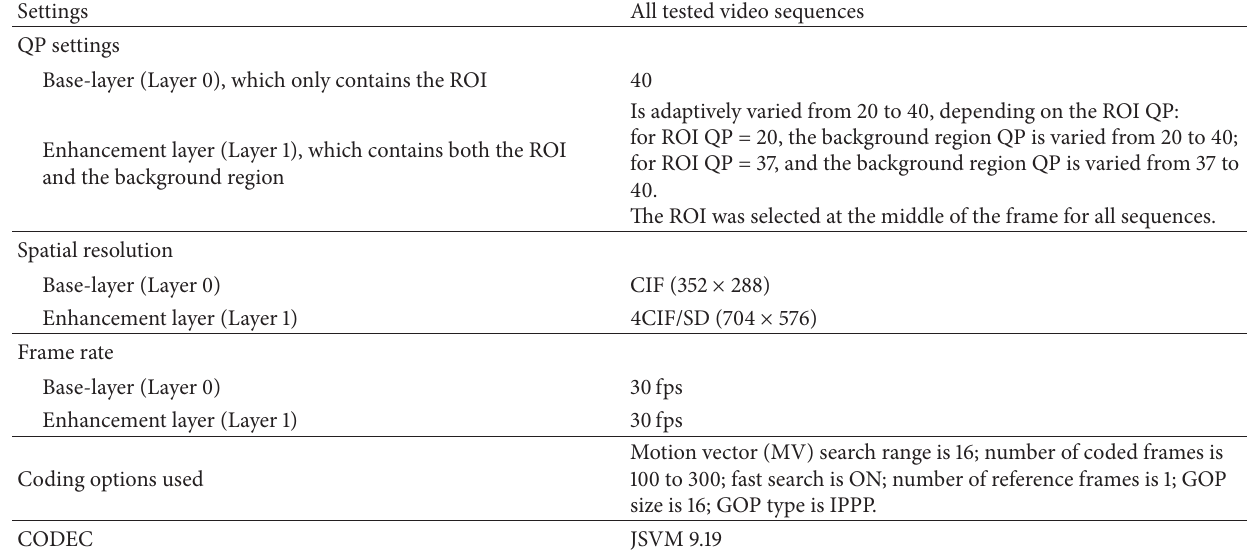
Table 7: Test conditions for performing the